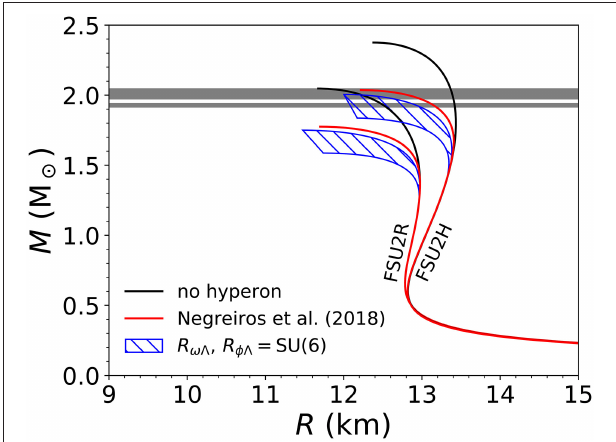
R relations for the FSU2R and FSU2H models. The gray FIGURE 2 | M − strips correspond to the mass of the two heaviest known NSs, PSR J1614 2230 and PSR J0348 0432. The black lines are obtained for purely − + nucleonic models, the red ones for the models presented in Negreiros et al. (2018). The blue stripped areas correspond to the mass range covered when employing the minimal and maximal hyperonic models for SU(6) values of the coupling constants R ω3 and R φ3 of the 3 hyperons, and, additionally, the SU(6) value of the coupling constant R ω6 , U 6 ( n 0 ) 0 MeV and = U 4 ( n 0 ) 14 MeV for the maximal hyperonic model—see Figure 1 = −